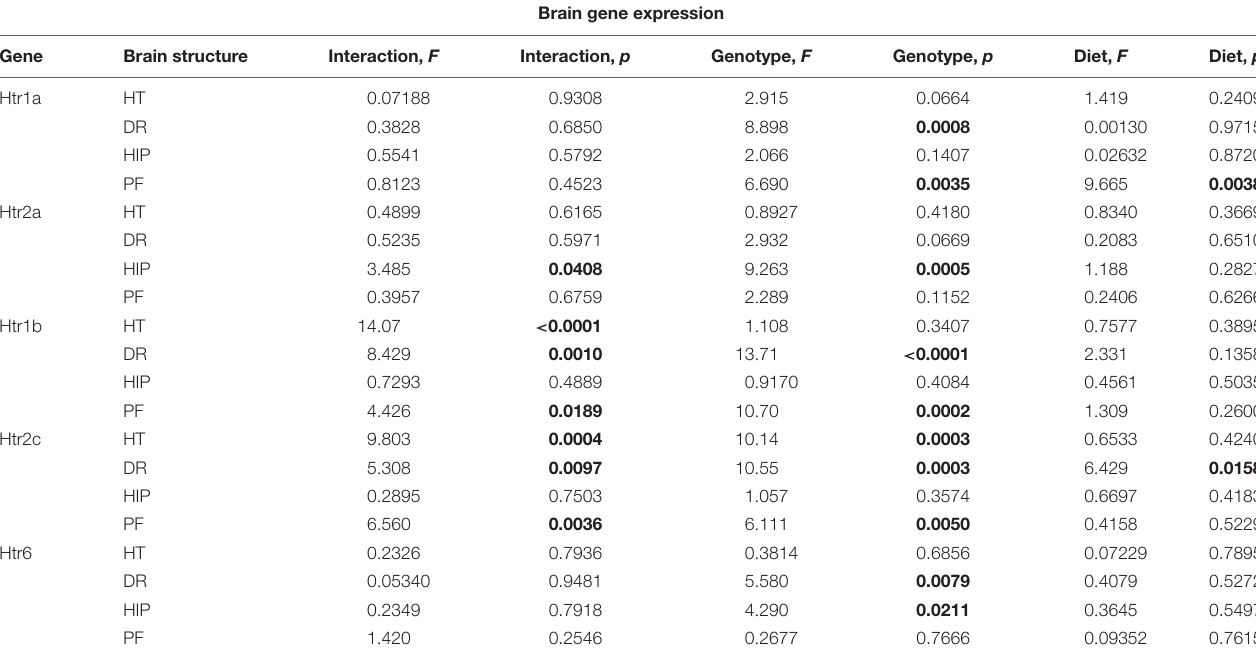
TABLE 3 | Two-way ANOVA results for statistical analysis of serotonin receptor gene expression. Brain gene expression Gene Brain structure Interaction, F Interaction, p Genotype, F Genotype, p Diet, F Diet,